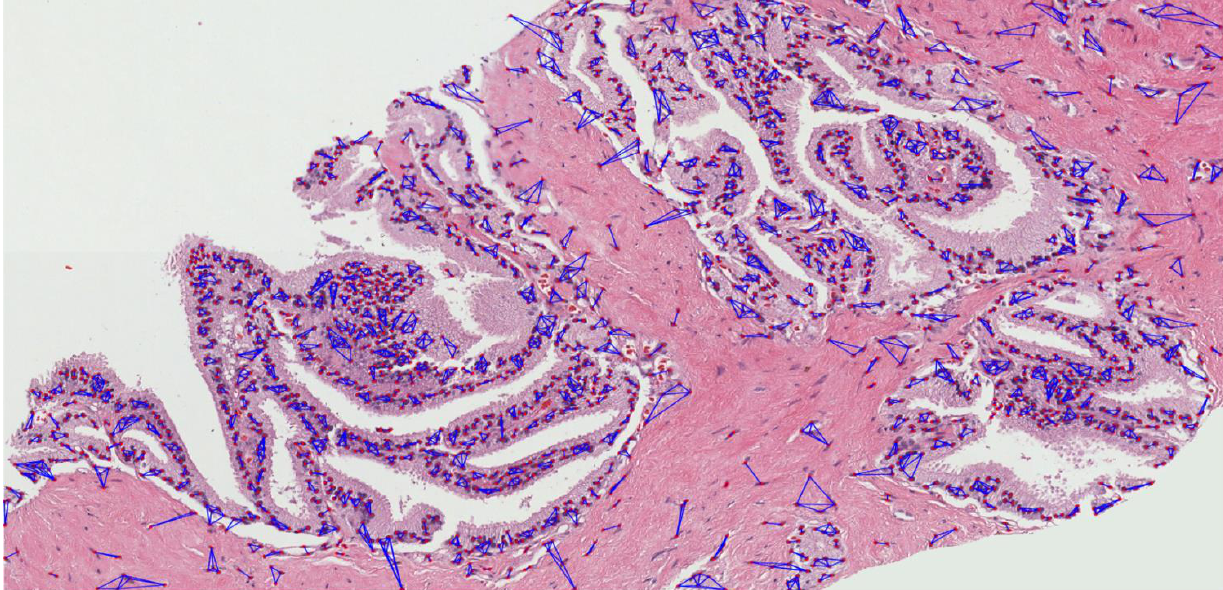
Figure A5. The proliferation and community structure of cell nuclei in the annotated region of grade 4.